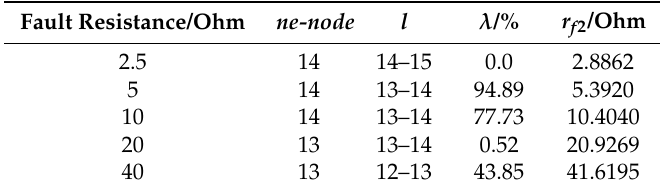
Table 10. Locating results of Strategy 2 with different fault resistances.